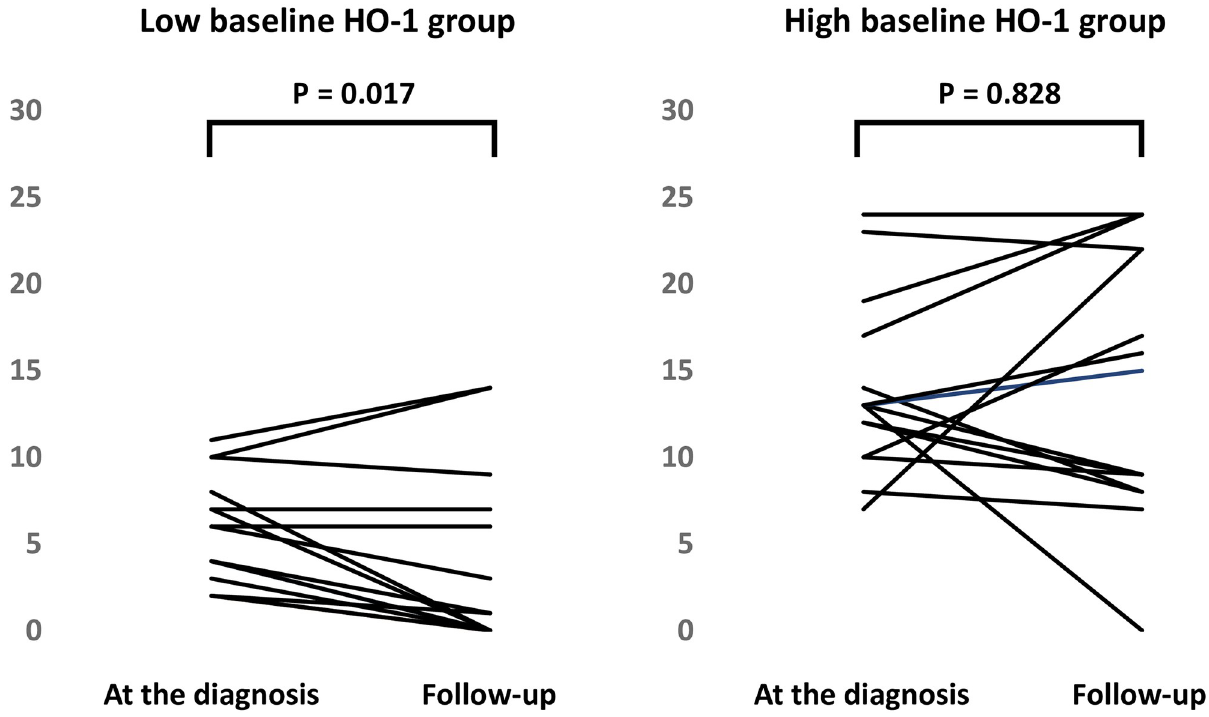
Fig 4. Relationship between baseline serum heme oxygenase (HO)-1 and the serial change of ground glass opacity (GGO) and consolidation score. We did follow up the HRCT scores in 31 patients and divided these cases into the low baseline HO-1 group (N = 16) and the high baseline HO-1 group (N = 15). We found that in the former group, the GGO and consolidation score were significantly decreased (A), while in the latter group, it was persistently high (B).